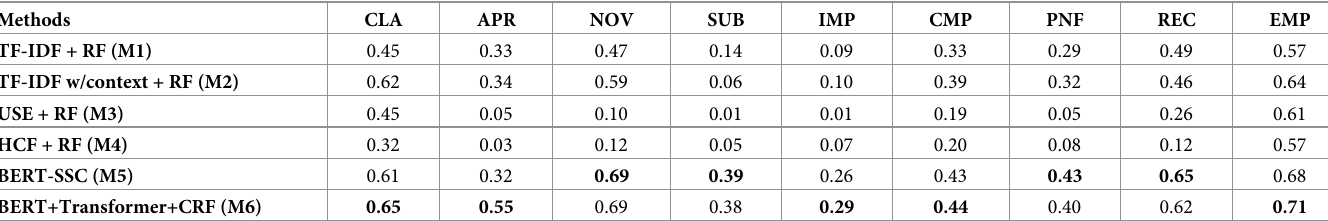
Table 6. Label-wise F1 scores (micro-averaged) for Task 2.